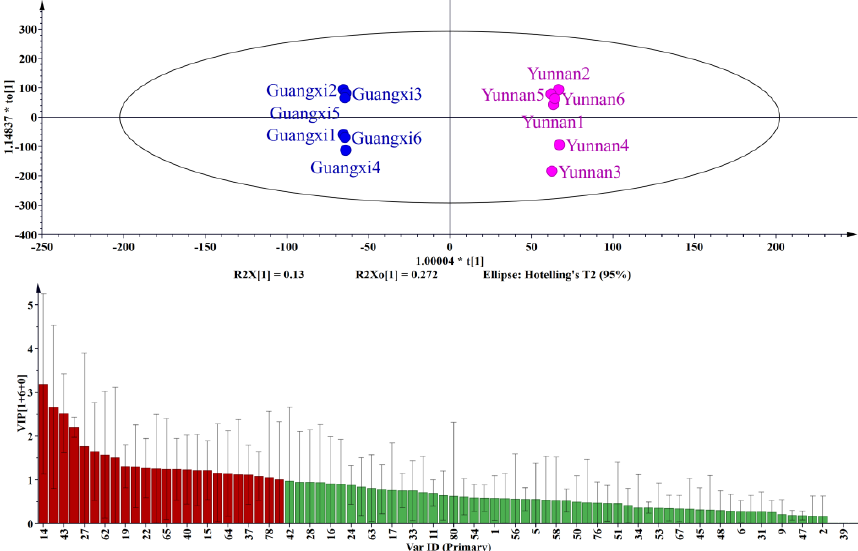
Figure 5. OPLS-DA analysis and VIP diagram of brown sugar in Guangxi and